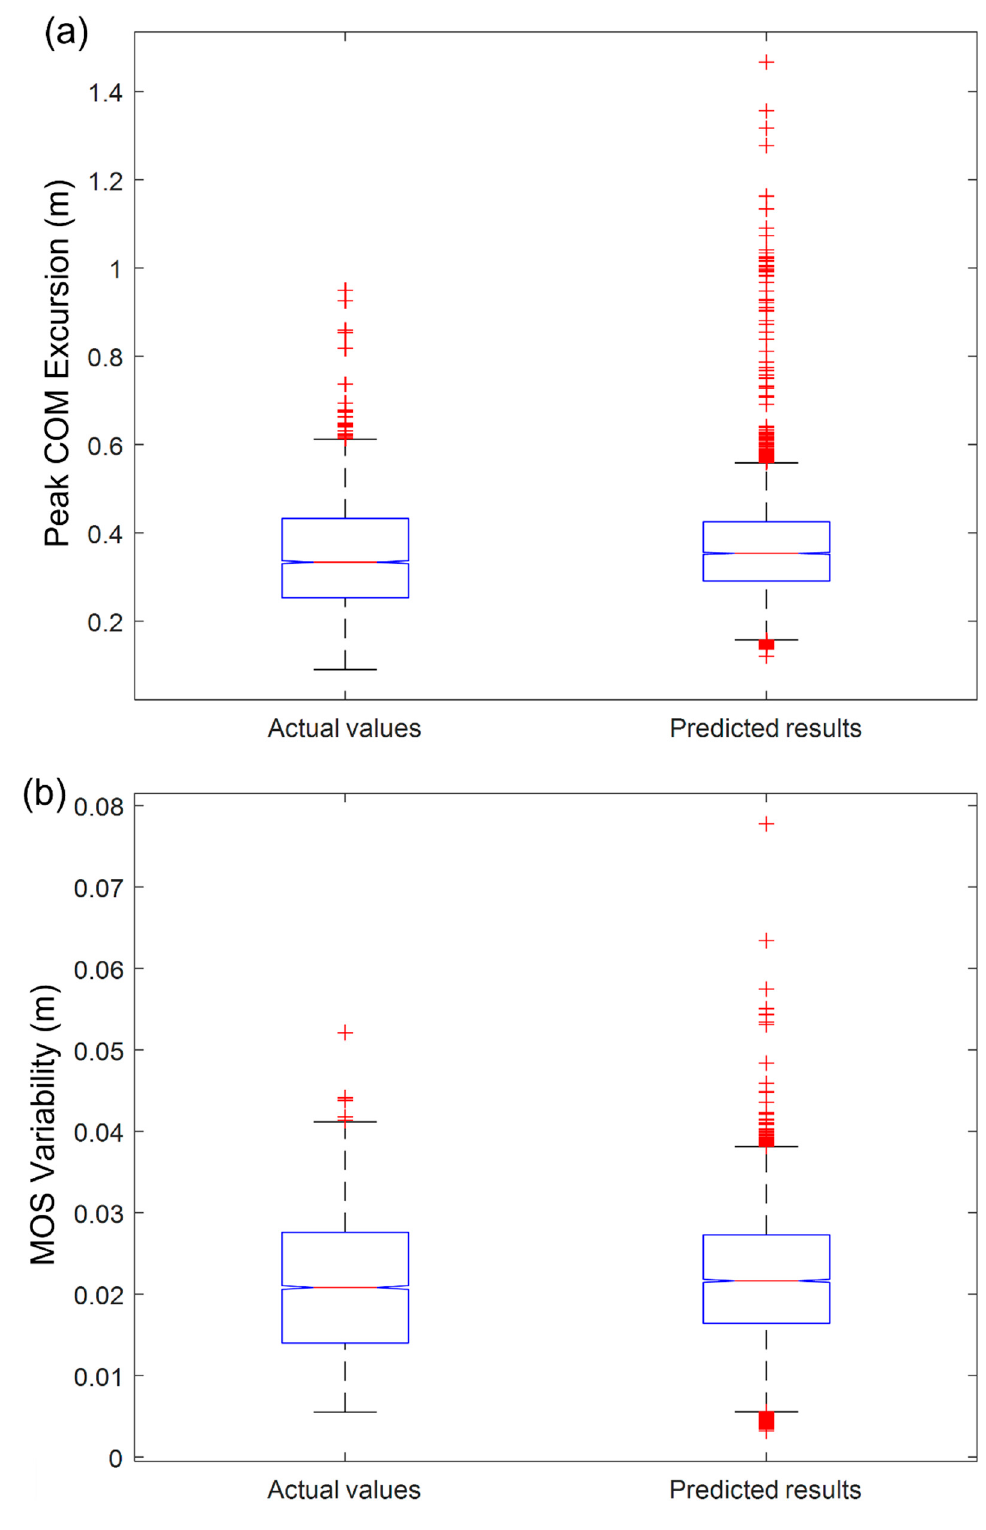
Figure 3. Comparison of the differences between actual values and predicted results for: ( a ) peak COM excursion and ( b ) MOS variability. COM excursion and ( b ) MOS